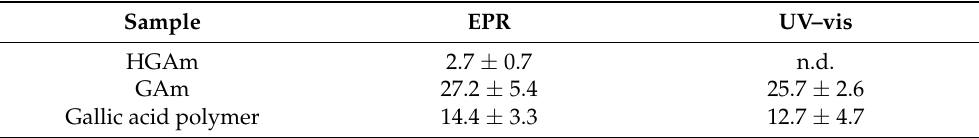
Table 3. EC 50 ( µ g/mL) values from DPPH assay.